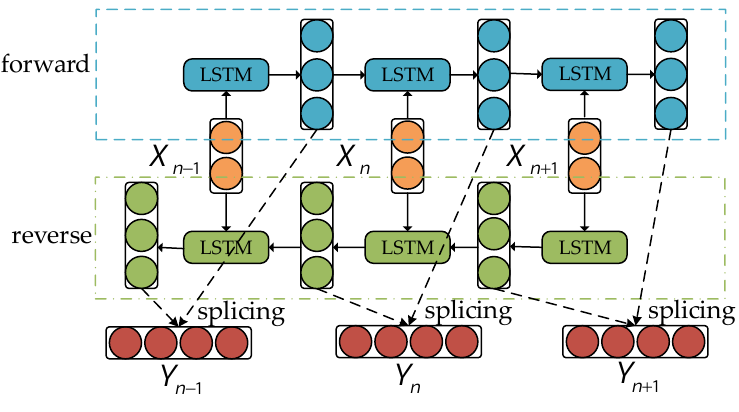
Figure 5. Bi-LSTM structure.